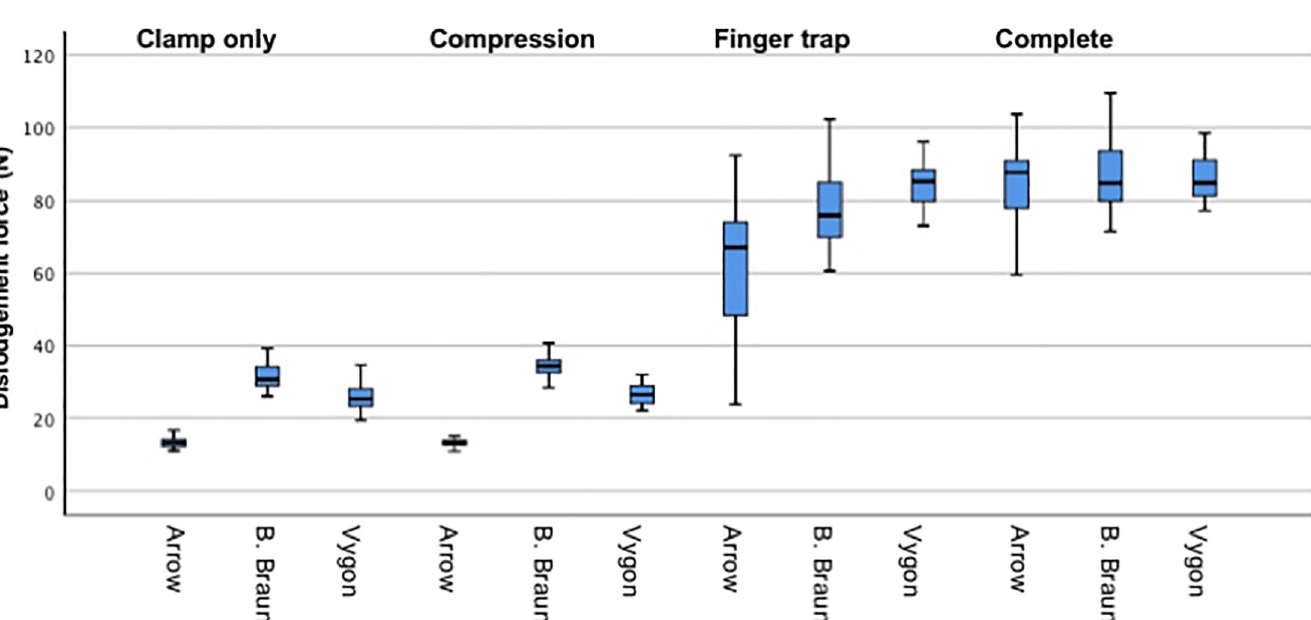
PLOS ONE | https://doi.org/10.1371/journal.pone.0222463 September 12,